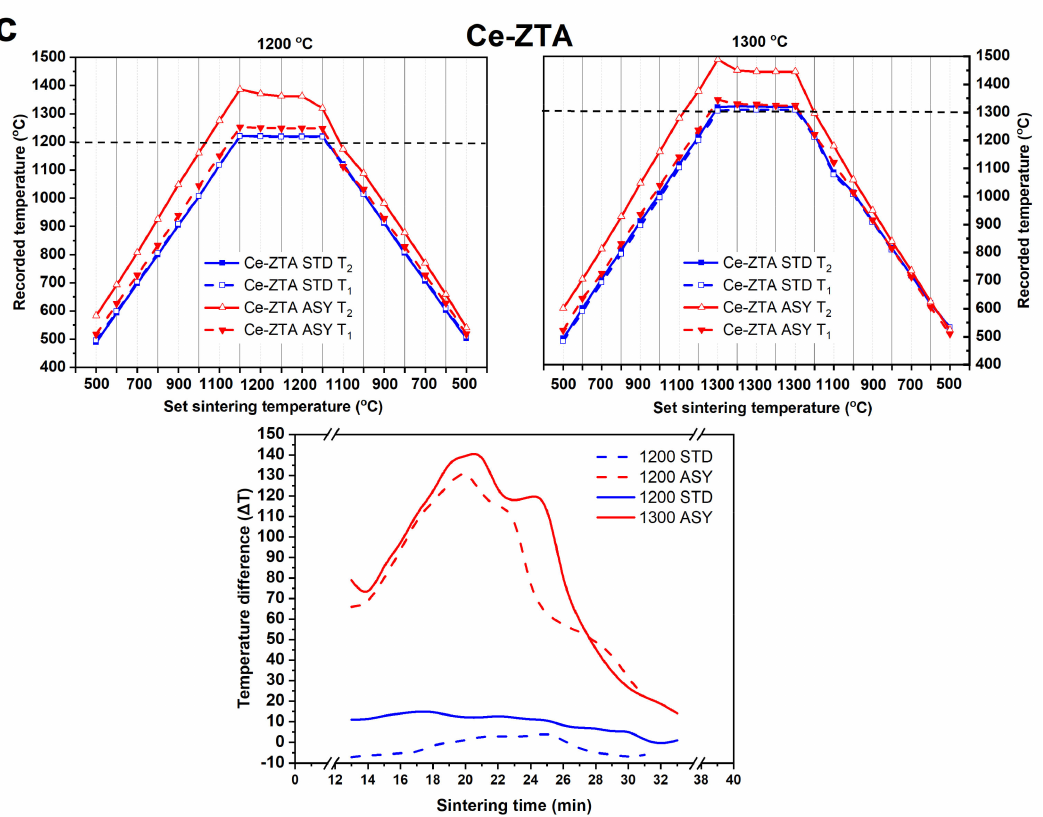
Figure 3. The top (T 1 ; full symbol) and bottom (T 2 ; empty symbol) temperatures of ( a ) Al 2 O 3 , ( b ) Y-ZTA, and ( c ) Ce-ZTA samples recorded in STD (blue line) and ASY (red line) at both sintering temperatures are shown as a function of the set temperature, measured by pyrometer (horizontal dash line illustrates the set temperatures). The calculated ∆ T with respect to sintering time for ASY and STD configurations are also